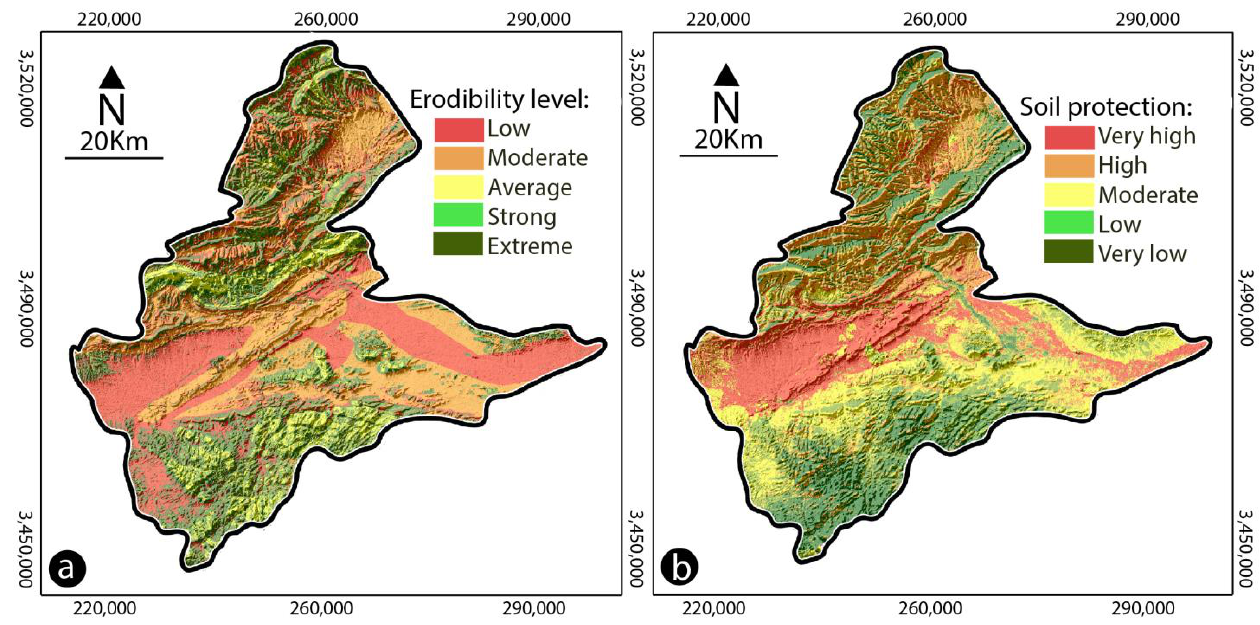
Figure 5. Maps of erodibility ( a ) and soil protection ( b ) according to the PAP/RAC